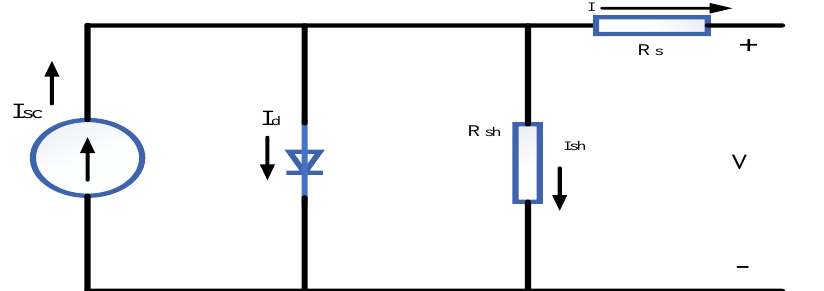
Figure 12. Equivalent Circuit PV Panel.